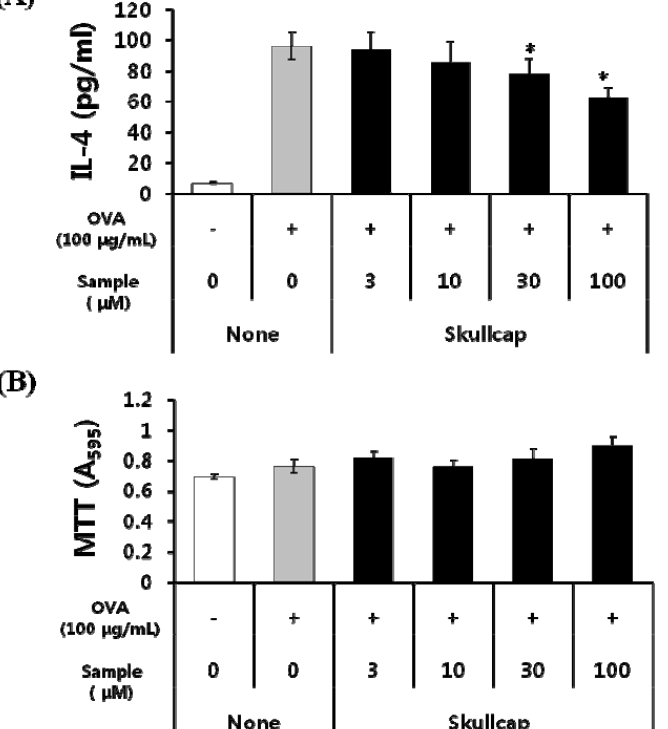
Figure 2. Effects of skullcap extract on OVA-induced Th2 immune response ex